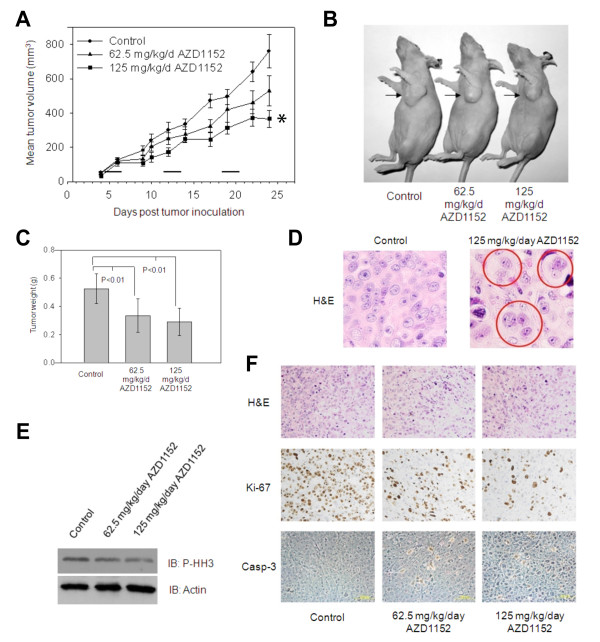
AZD1152 inhibits orthotopically xenografted HER18 cells in nude mice. (A) Tumor growth curves for orthotopically implanted HER18 cells are shown. Control mice received vehicle (0.3 M Tris pH 9.0), low dose mice received 62.5 mg/kg/dose AZD1152, and high dose mice received 125 mg/kg/dose AZD1152. Treatment began when tumors were measurable (approximately 50 mm3). Injections were given IP on days 1 and 2 of 7-day cycles, indicated by horizontal bars just above the x-axis. * P < 0.001 calculated as a mixed linear model. Error bars represent SE. (B) Representative mice bearing xenografts (arrows) from each treatment group. (C) Weights of dissected xenografts are plotted as means for each treatment group. Error bars represent 95% confidence intervals. P values were determined by one-way ANOVA. (D) H&E stained control and high dose (125 mg/kg/day) tumor samples are shown. Multi-nucleate cells (circles) were observed in tumor sections from AZD1152-treated mice but not in control mice. (E) Western blots using anti-phospho-Histone H3 and anti-actin are shown as labeled. (F) Histology and immunohistochemistry of xenografts are shown: top panels- H&E staining; middle panels- immunohistochemistry with antibodies for Ki-67; lower panels- cleaved Caspase 3.